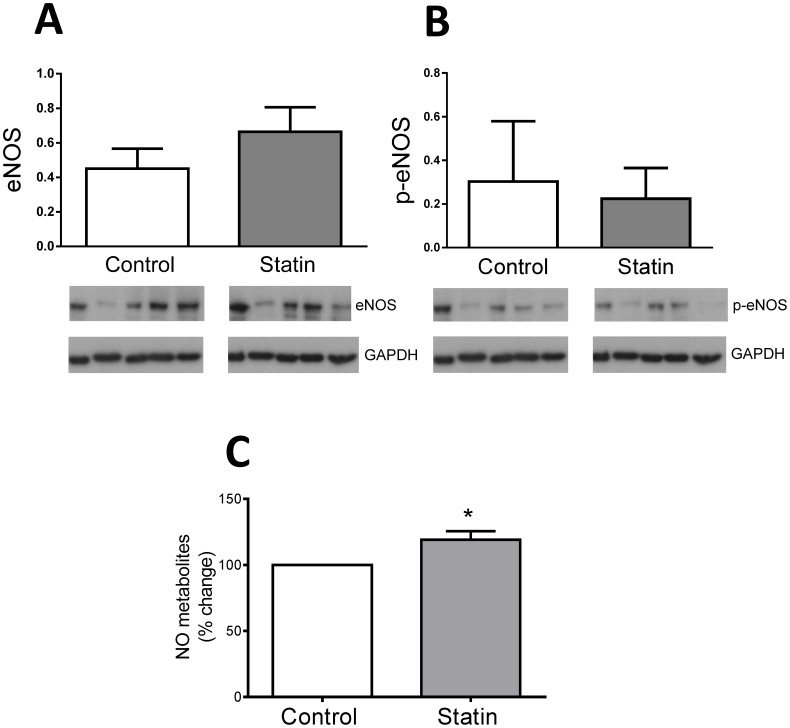
The effect of simvastatin on eNOS and NO production.A. Total eNOS expression normalised to GAPDH in control and simvastatin-treated cells. B. Ser1177-phosphorylated eNOS normalised to GAPDH in control and simvastatin-treated cells. Data are from cells from n = 5 hearts. C. Medium was collected from myocytes cultured for 48 h in the presence or absence of simvastatin. NO metabolites (nitrate/nitrite) were measured by a fluorimetric assay. Data are [nitrite + nitrate] normalised to values in paired control group (cells from n = 6 hearts). * P<0.05, Student's t-test.